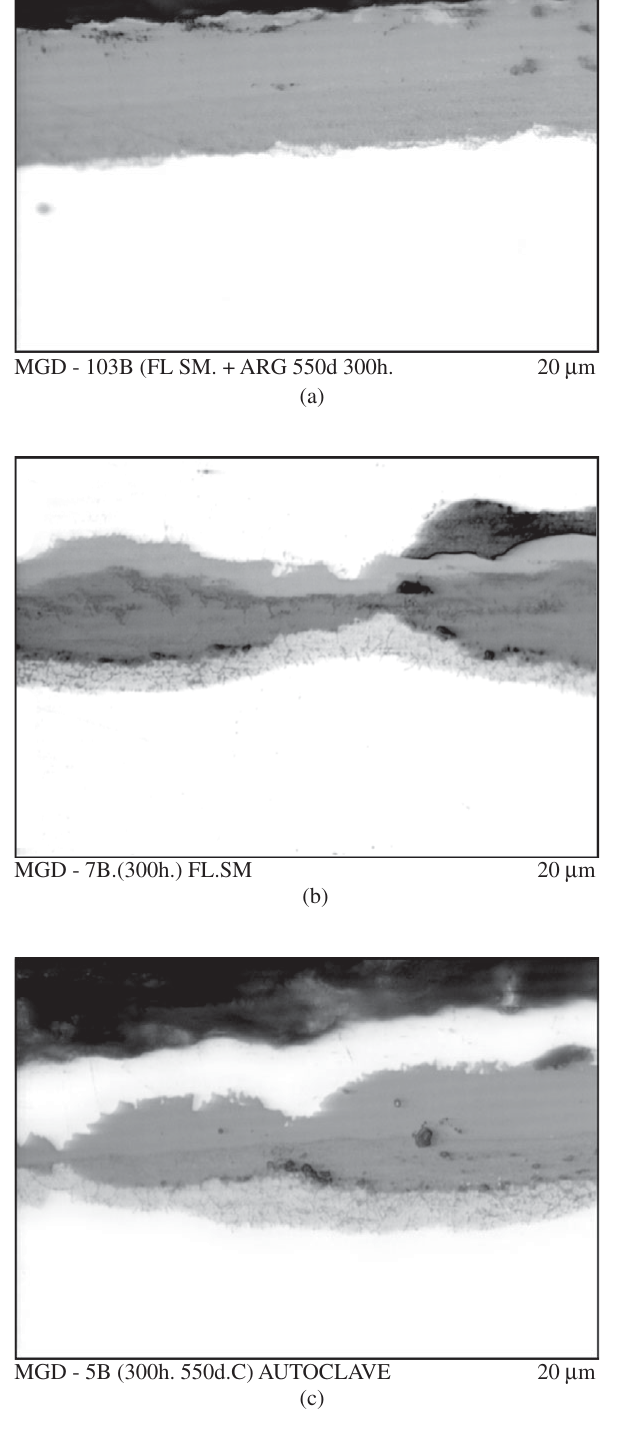
Figure 5. Probability plot of oxide scale thickness for 9Cr1Mo(2) material, exposed to steam at 550 °C using various